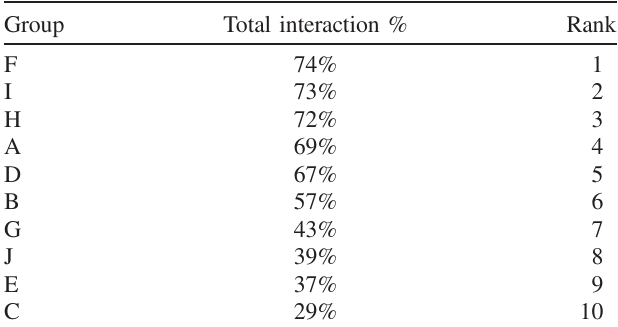
TABLE III. Total time spent talking about the topic averaged across three episodes. Note: because some segments are longer than others, they carry more weight in the average.